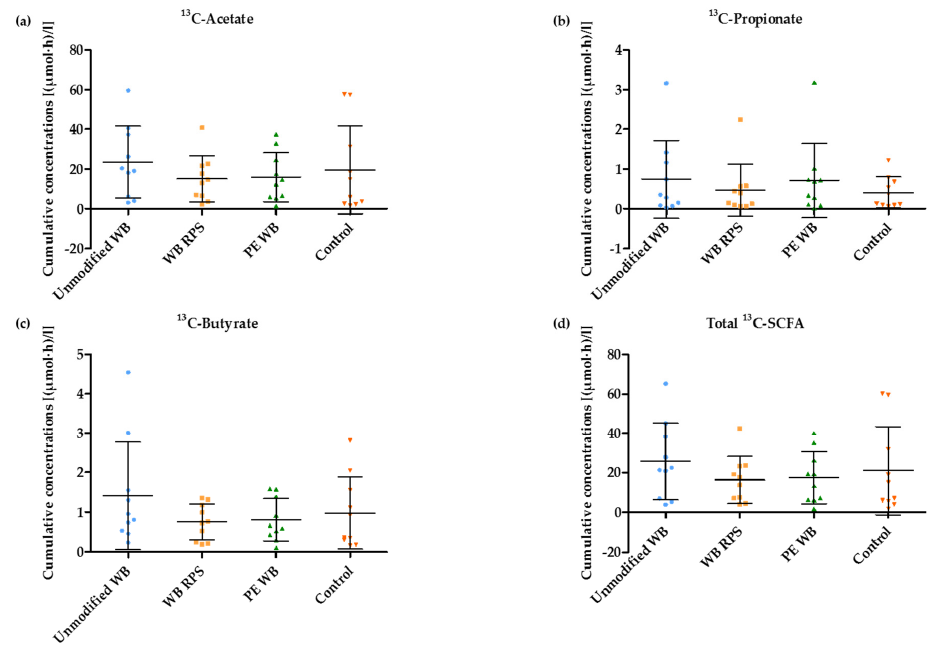
Figure 8. Wheat bran (WB) supplementation did not affect the cumulative 13 C ‐ acetate ( a ), 13 C ‐ propionate ( b ), 13 C ‐ butyrate ( c ), total 13 C ‐ SCFA ( d ) concentrations in plasma ( n = 10). The middle line represents the mean with the standard deviation